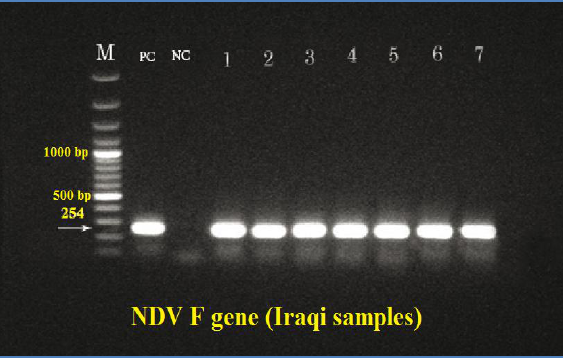
Figure, 1: Showing the results of RT-PCR (254 bp) resulting from virulent NDV isolates the adoption of primer pair, where M =